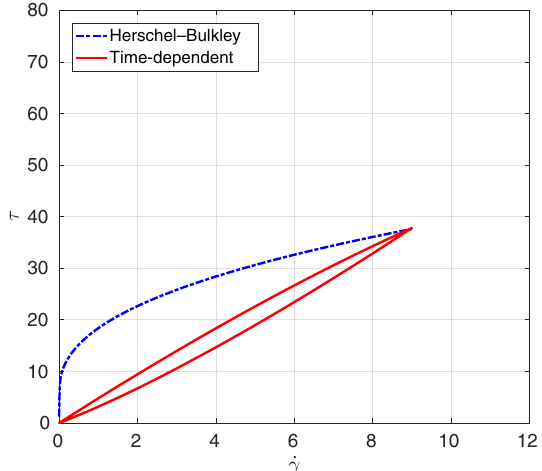
Figure 12. Subaqueous debris case 2: shear stress (Pa) and rate of strain (s − 1 ). Axis scalings are identical to Fig. 11 for comparison purposes.